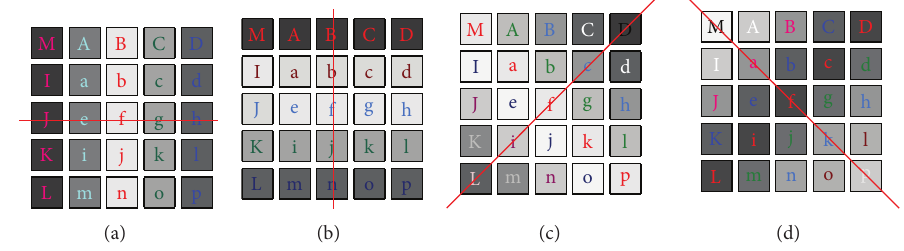
Figure2:(a)The 5×5 blockhorizontalhomogeneouspixelsandtheircorrespondingsymmetryaxes.(b)The 5×5 blockverticalhomogeneous pixels and their corresponding symmetry axes. (c) The 5 × 5 block diagonal-right homogeneous pixels and their corresponding symmetry axes. (d) The 5 × 5 block diagonal-left homogeneous pixels and their corresponding symmetry axes.